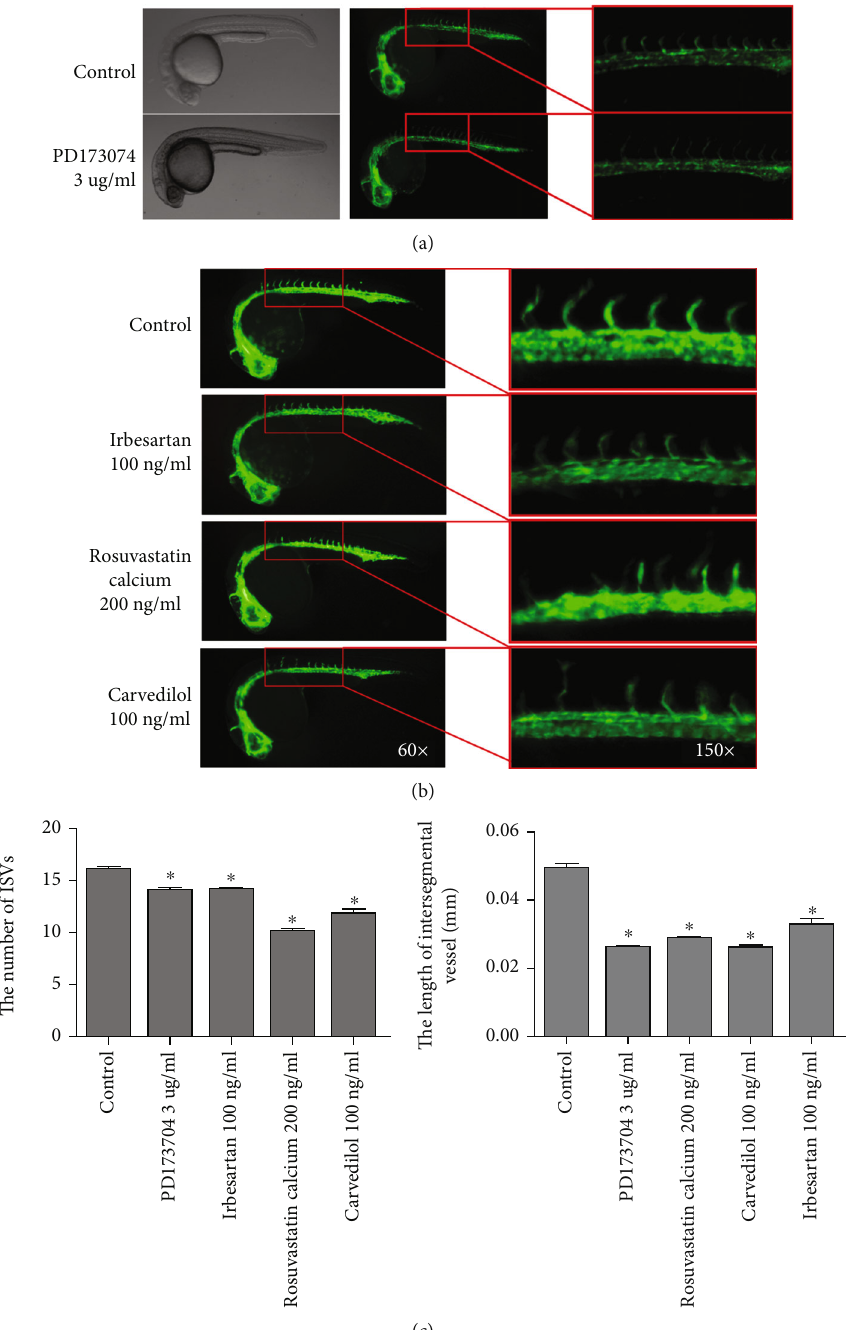
Figure 3: E ff ects of antiangiogenic drugs on ISV formation in Tg ( fl k1: EGFP) zebra fi sh embryos. (a) Bright- fi eld and fl uorescent images of zebra fi sh embryos at 24hpf treated with 0.5% DMSO (control) and 3 μ g/ml PD173074 (positive control) for 24 h. (b) Fluorescent images of zebra fi sh embryos treated for 24h with the antiangiogenic agents identi fi ed. Control: embryo treated with 0.5% DMSO. (c) Average number and length of ISVs was signi fi cantly inhibited, compared with the control, by the drugs at their optimal concentrations. Columns represent the mean of three independent experiments ( n = 20 ). ∗ P < 0 : 05 vs. control